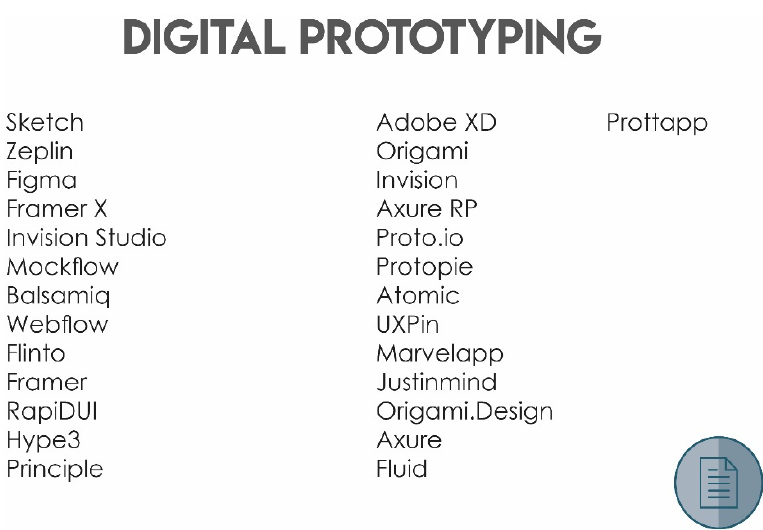
Figure 7. Example of a reference card.